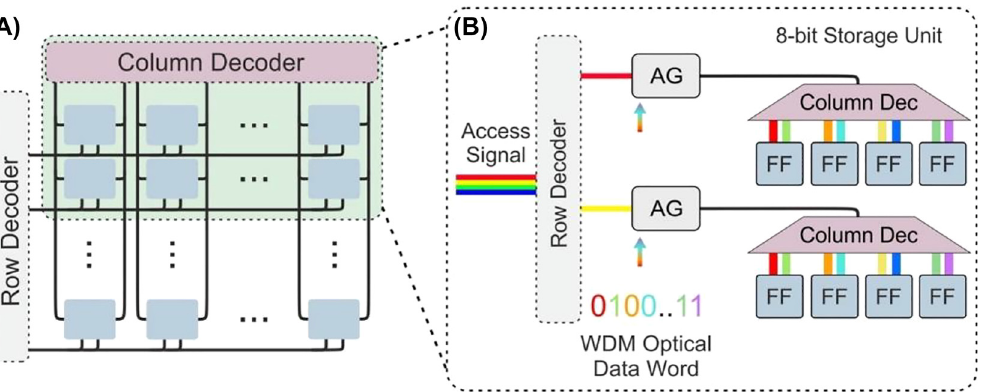
Figure 14: Computing with digital photonic memories. (A) Concept of a 2D 4 × 4 optical RAM bank and (B) 16-bit optical storage unit with a single row decoder unit and simultaneous operation in both rows with a passive column decoder in each